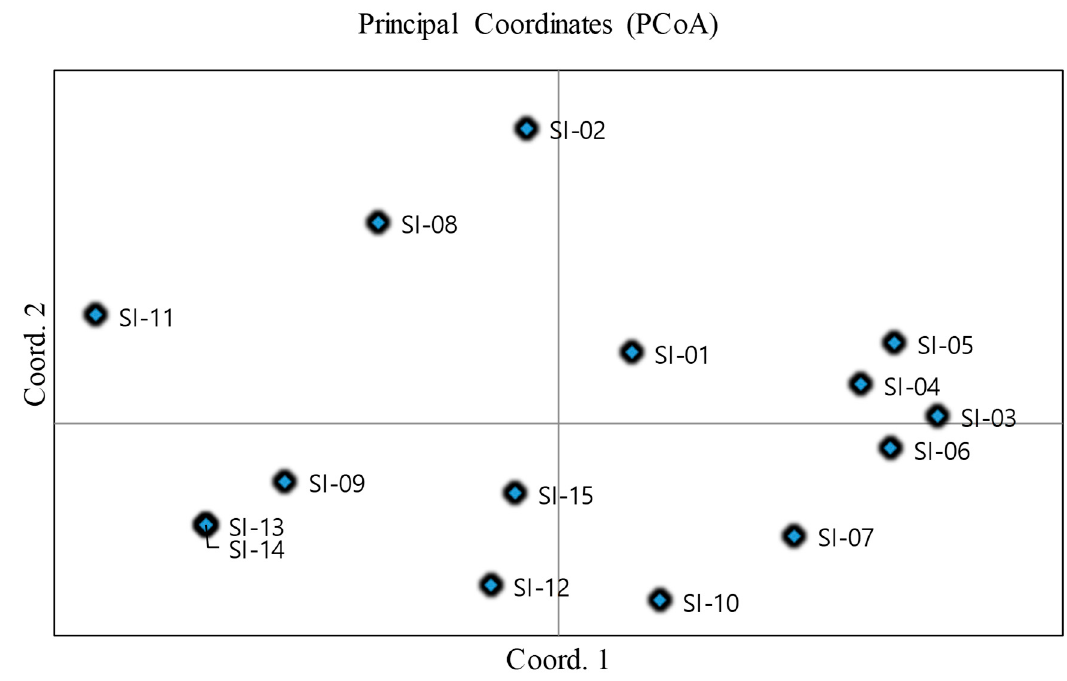
Figure 5. Two-dimensional plot of PC1 and PC2 principal coordinates analysis in the 15 accessions in S. italica based on phenolic compounds.